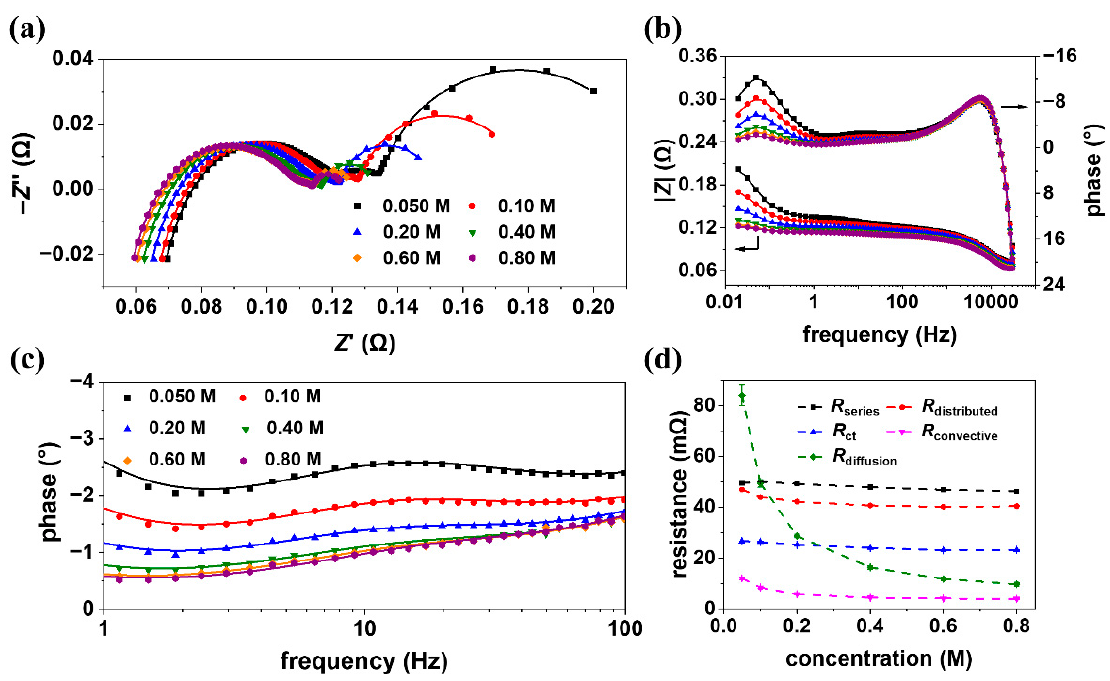
Figure 3. Effect of electrolyte concentrations on full cell impedance. ( a ) Nyquist plots; ( b ) Bode plots; ( c ) Bode phase plots in 100 Hz–1 Hz; ( d ) Resistance value derived from the data fitting. The cell was assembled using 5 mm electrodes. The impedance spectra were recorded at OCV at a constant electrolyte velocity of 60 mL min − 1 . The symbols and the solid lines in Nyquist and Bode plots show the experimental and the fitted data, respectively.